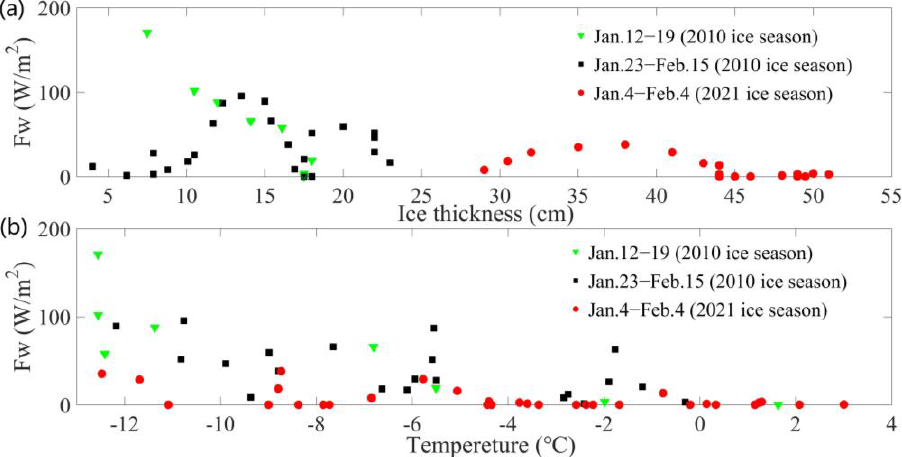
Figure 12. ( a ) The relationship between bottom heat flux and ice thickness; ( b ) the relationship between bottom heat flux and temperature. Table 3. The oceanic heat flux during the rapid growth process of ice thickness.